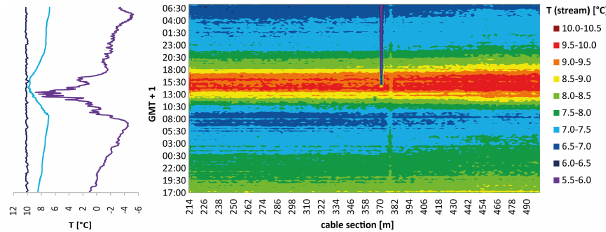
Figure 5. Air (purple), stream (light blue) and groundwater (dark blue) temperature (line diagram, left side) and surface water temper- atures (colour plot, right side) of the Chriesbach before river restora- tion, on 13–15 March 2013. The x axis of the colour plot shows the sections of the fibre-optic cable in metres; the colours represent the surface water temperatures in ◦ C. Thereby, each coloured line on the x axis, from cable section 214 to 501m, represents one mea- surement. The y axis states the time of the measurements.